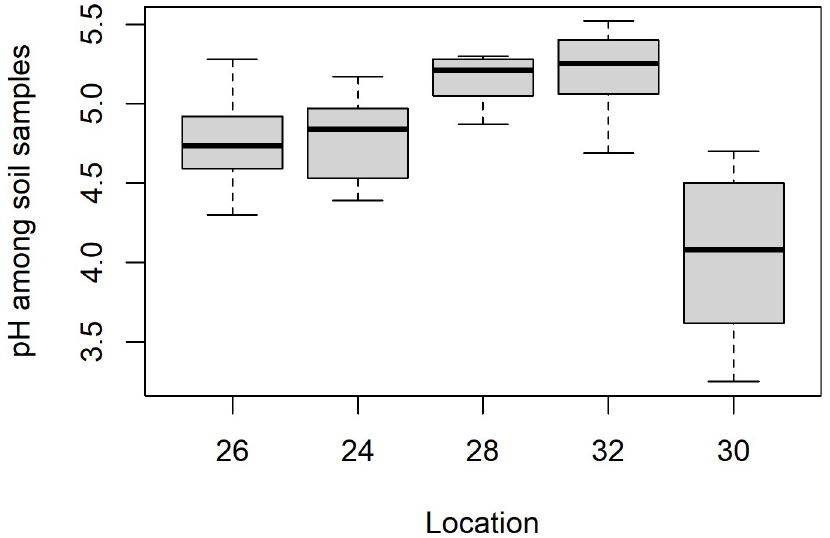
Fig 4. Boxplot of pH of soil samples among localities within Mining